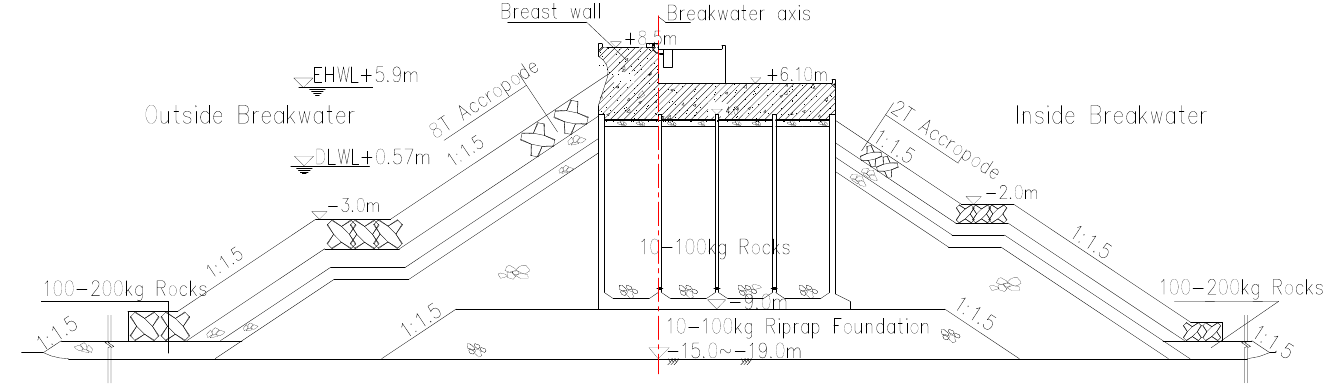
Figure 3. Cross-section of the transition of the different structures.